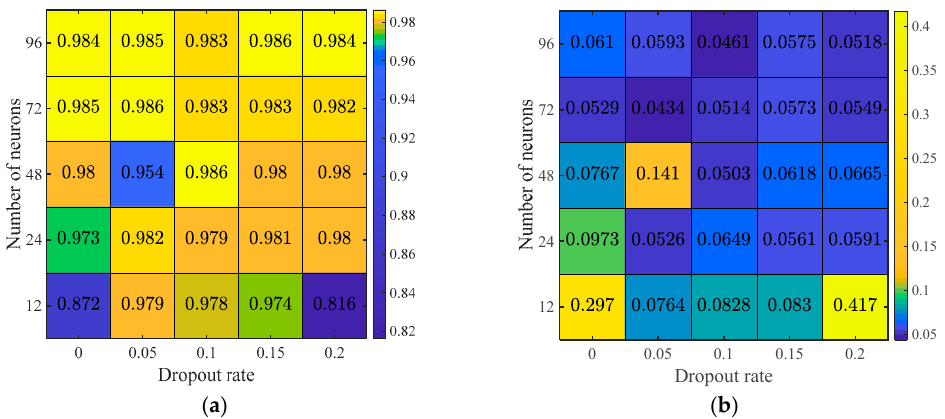
Figure 11. Performance for different combinations of the number of neurons in the first full connection layer and dropout rate in terms of the ( a ) average test accuracy and ( b ) average test loss value.